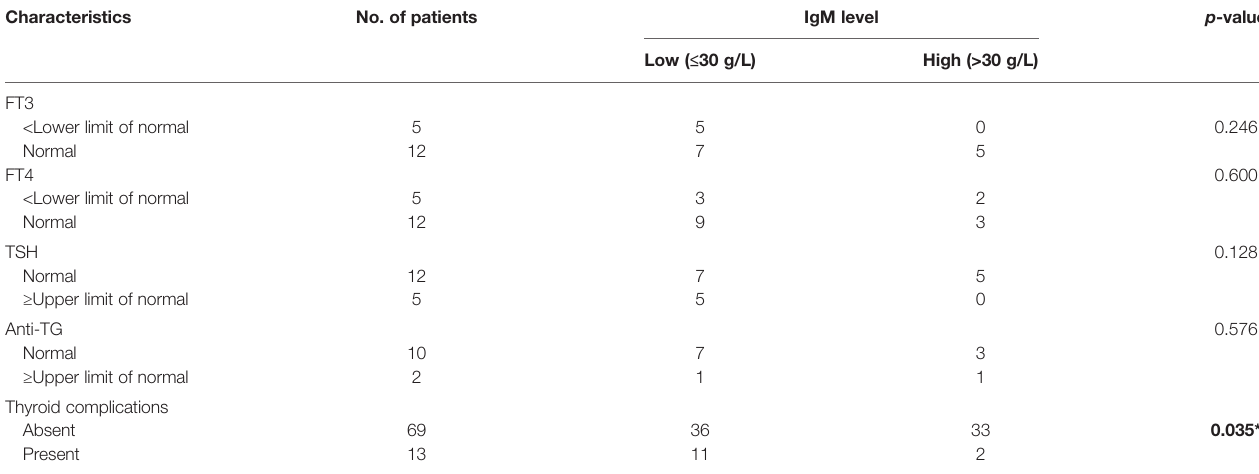
TABLE 2 | Relationship between thyroid complications and serum immunoglobulin M (IgM) level in WM/LPL.